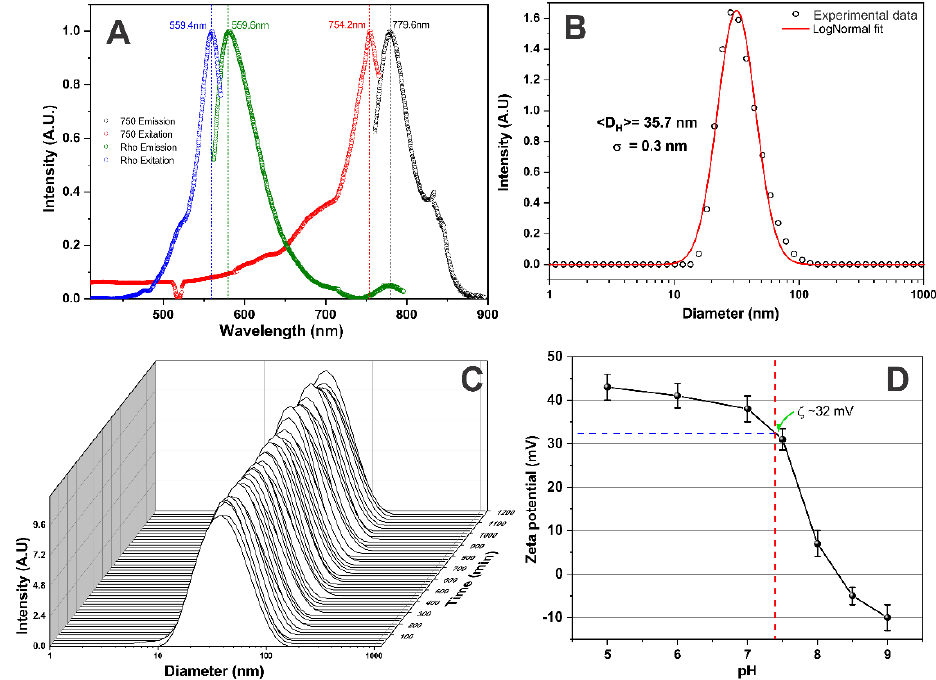
Figure 3. M-SPION characterizations: ( A ) M-SPION excitation/emission spectrum, showing the double fluorescence. ( B ) The curve of M-SPION size polydispersion. ( C ) The temporal stability analysis of M-SPIONs dispersed in culture medium (DMEM with 10% FBS). ( D ) Zeta potential as a function of the pH of the M-SPION solution.